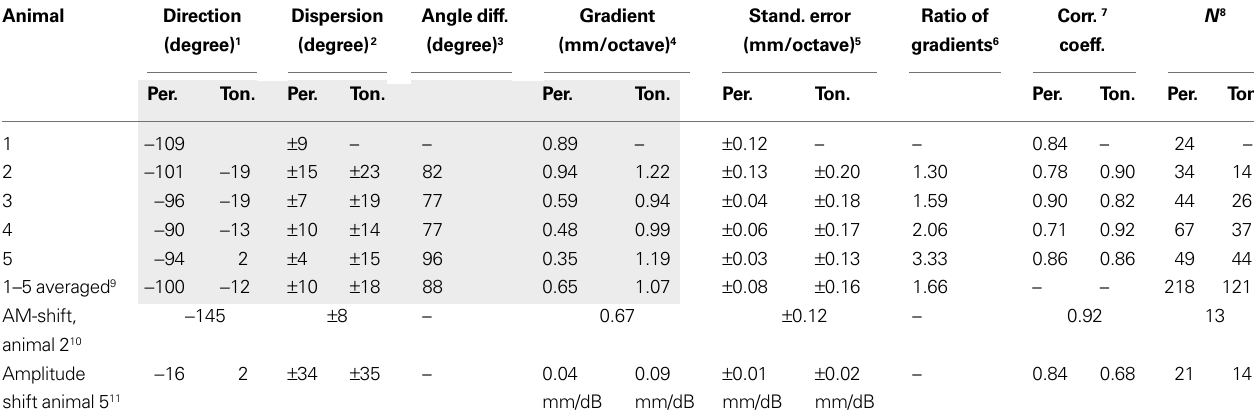
Table 1 | Multiple regression analysis of circular distribution of gradients of tonotopic and periodotopic organization. This was computed from centers of gravity of optical refl ectance changes in single condition maps obtained from N = 218 response maps to harmonic sounds and N = 121 response maps to pure tones ( P < 0.001). Column 1: Direction of maximal gradients for different experiments. The averages of experiments 1–5 were defi ned by circular statistics of the results from single experiments (row 9) (0º = rostro-caudal). Column 2: Dispersion corresponding to standard errors. Column 3: Difference of angles between tonotopic and periodotopic gradients as given in 1. Column 4: Size of maximal gradients expressed in mm/octave. Column 5: Standard errors of maximal gradients expressed in mm/octave. Column 6: Ratios of gradients as given in column 5. Column 7: Correlation coeffi cients of linear regression. Column 8: Number of cases; extreme values from individual SCMs were excluded using the Nalimov-test. Row 9: see above. Row 10: Results from an experiment where carrier frequencies of 0.8, 1.6, and 3.2 kHz were amplitude modulated by 50, 100, 200, or 400 Hz. Row 11: Results from responses to harmonic sounds with different amplitudes between 0 and 40 dB